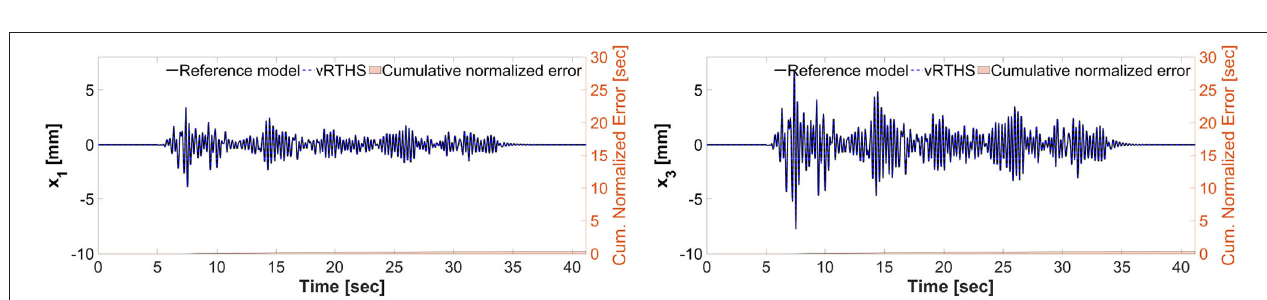
FIGURE 16 | Study 3 (Case 1): vRTHS response comparisons of the 1st and 3rd floor displacements under El Centro excitation.